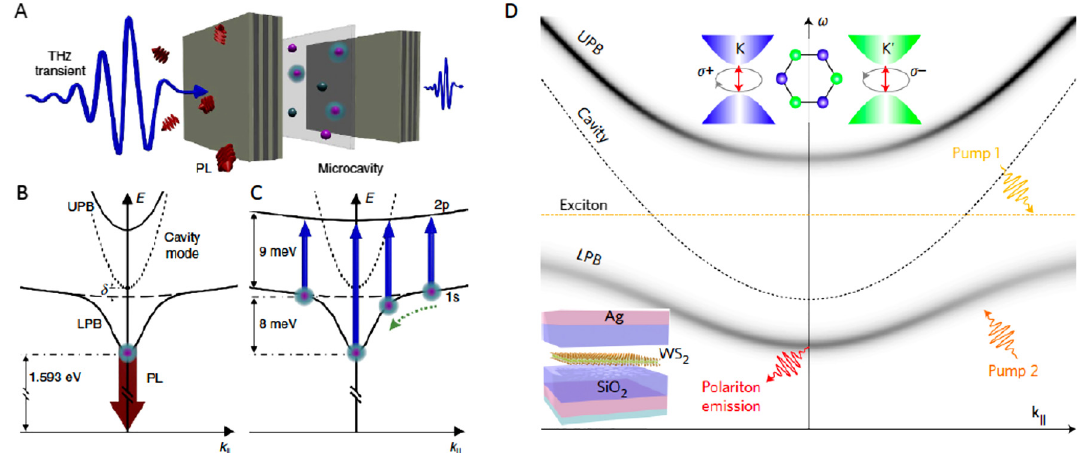
Figure 4: Cavity exciton polaritons. Panel A: polaritons (pink spheres with blue halo) emerge from strong coupling between the excitonic resonance in a quantum well (transparent sheet) and the photonic mode of a GaAs/AlGaAs microcavity. THz probing (blue curve) maps out the matter component of the polaritons, while photoluminesce(PL,redarrows)leakingthroughaBraggmirrorrevealsthephotoniccomponent.PanelB:normal-modesplitting.Theheavyhole1 s excitonresonance(dashedcurve)andthephotonicmode(dottedcurve)arereplacedbytheupperpolaritonbranchandlowerpolaritonbranch(UPB andLPB,respectively;solidcurves).PL(thickredarrow)originatesfromtheradiativedecayofpolaritonsatsmallin-planemomenta k || .PanelC:THz absorptionprobeshydrogen-likeintraexcitonictransitions.Whilethe1 s stateisspectrallyshiftedbystronglight – mattercoupling,theopticallydark 2 p exciton is not affected by the cavity. The resulting momentum dependence of the THz transition energy allows us to map out the momentum distribution of the polaritons as they relax toward k || = 0 (green dotted arrow). From a study by M ´ enard et al. [174]. Panel D: schematic of the valley excitonpolaritonphenomena.Thesolid(gray) curvesindicateLPBandUPB.Thebarecavityandtheexcitondispersionareshownbytheblackand orange dashed curves, respectively. Pump 1 is used to excite directly the exciton reservoir, whereas pump 2 excites the lower polariton branch at speci fi c k || and ω . The emission is collected at smaller angles. The top inset shows the valley polarization phenomena in 2D transition metal dichalcogenide (TMDC) semiconductors caused by the broken inversion symmetry. In these materials, the K and K ′ points correspond to the band edges separated in momentum space but energetically degenerate. The bottom inset is a schematic of the microcavity structure with silver and a SiO 2 cavity layer embedded with prototypical TMDC materials WS 2 . From a study by Sun et al.